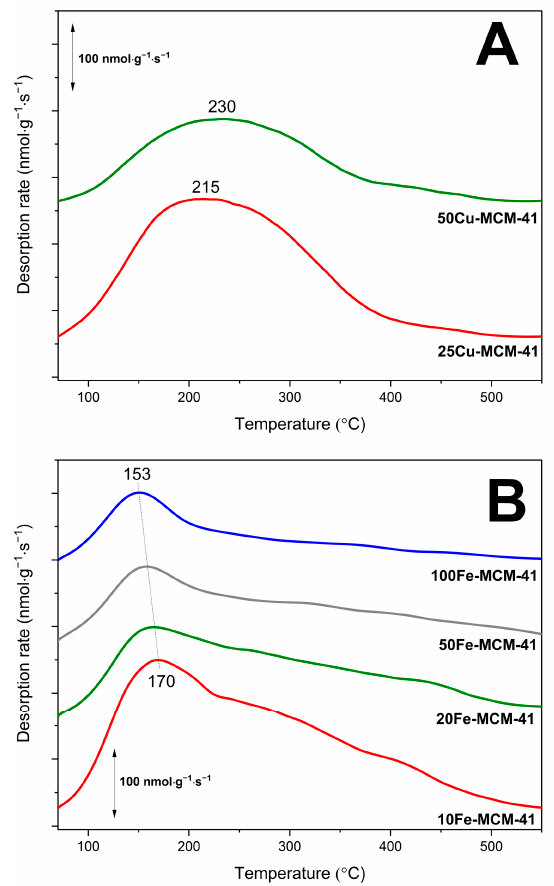
Figure 8. NH 3 -TPD profiles of spherical MCM-41 modified with copper ( A ) and iron ( B